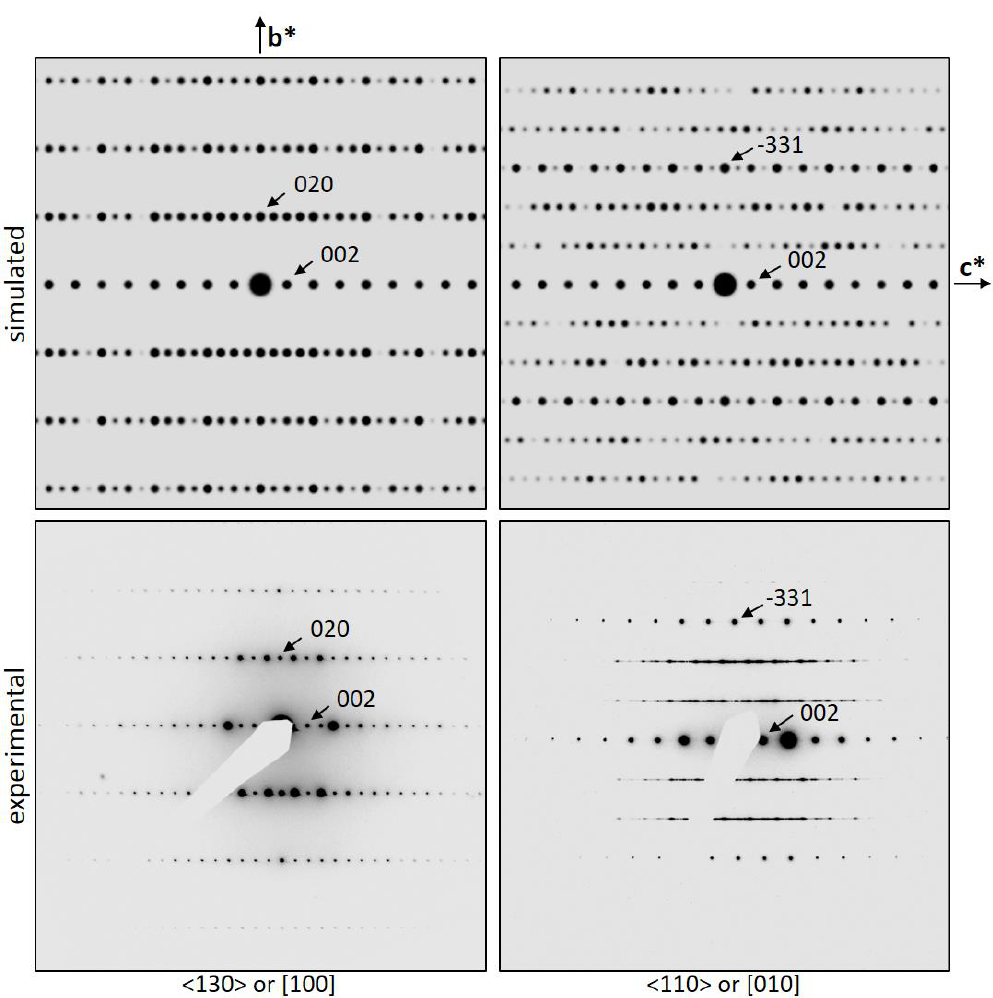
Figure 7. First row: kinematic simulations of SAED patterns along [100] (left), which is indistinguishable from (cid:104) 130 (cid:105) , and (cid:104) 110 (cid:105) (right), which is indistinguishable in case of dynamical scattering from [010] (indexing according to [010]). These patterns alternate every ~30 ◦ rotating the crystal around c* . Second row: corresponding experimental images. Note that: i) 00 l reflection with l (cid:44) 2 n may be present in experimental images because of dynamical scattering, and ii) the di ff use streaking a ff ecting hhl rows, h (cid:44) 3 n in (cid:104) 110 (cid:105) patterns.